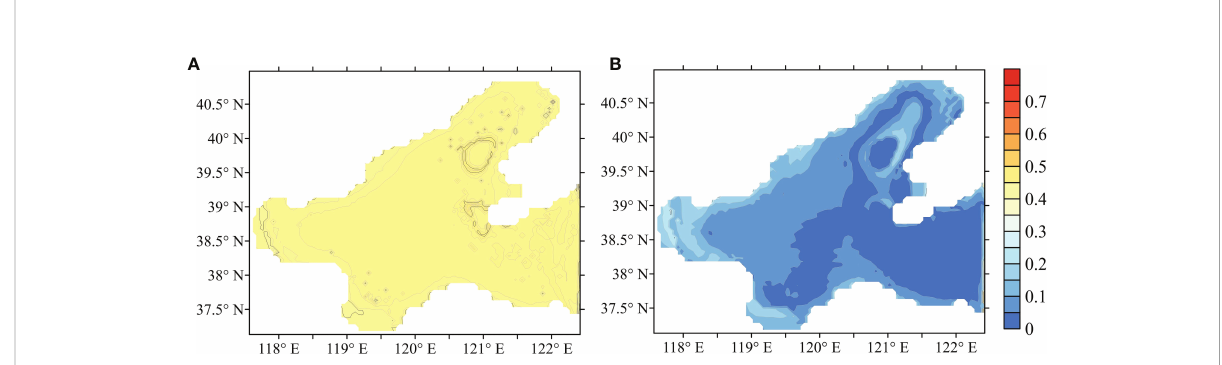
FIGURE 5 Temperature fi elds from the differences between (A) Truth and B_ IN, (B) Truth and optimal initial fi eld